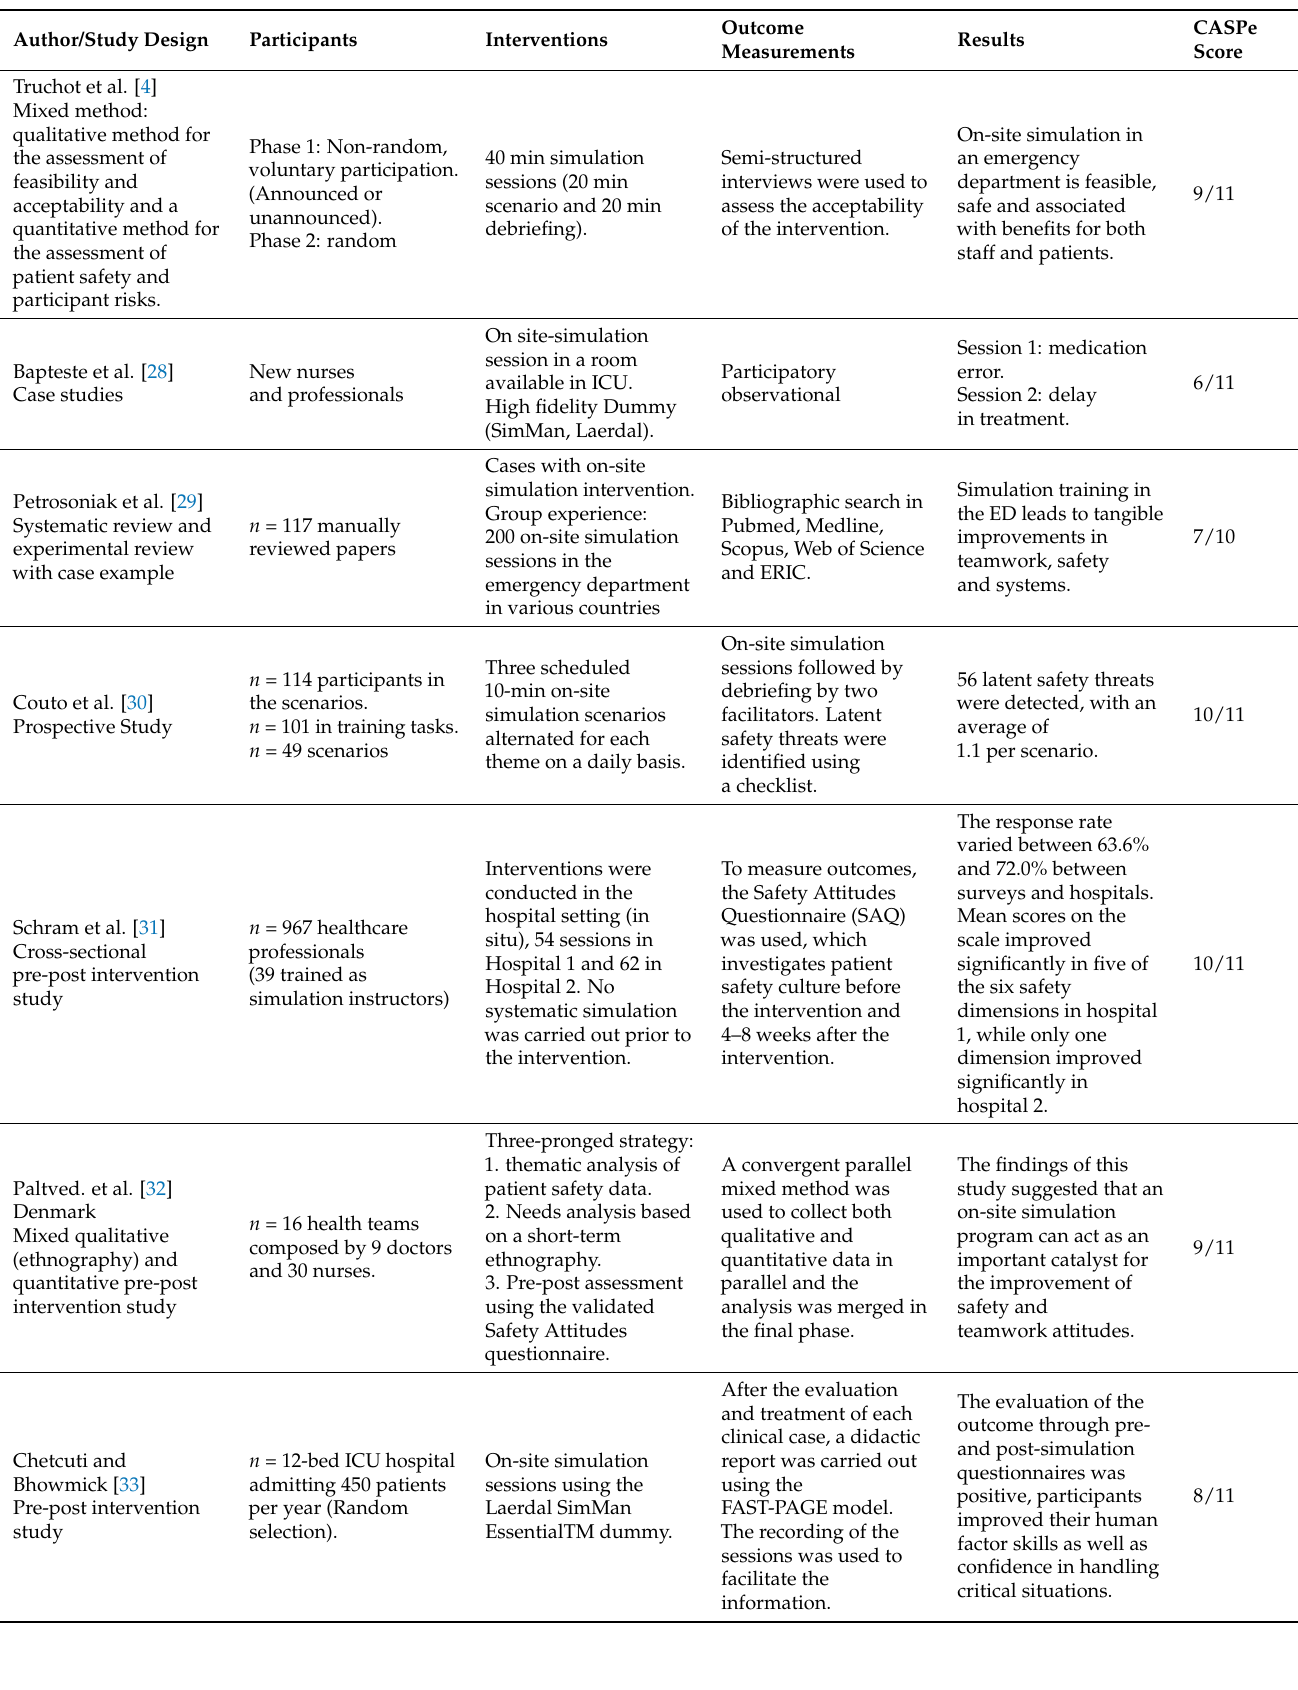
Table 2. Effect of on-site simulation